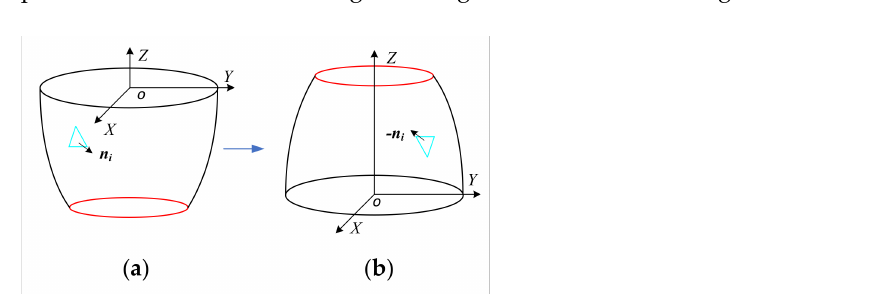
Figure 11. Turn-over transformation of the straight-wall model: ( a ) before overturn; ( b ) after overturn.